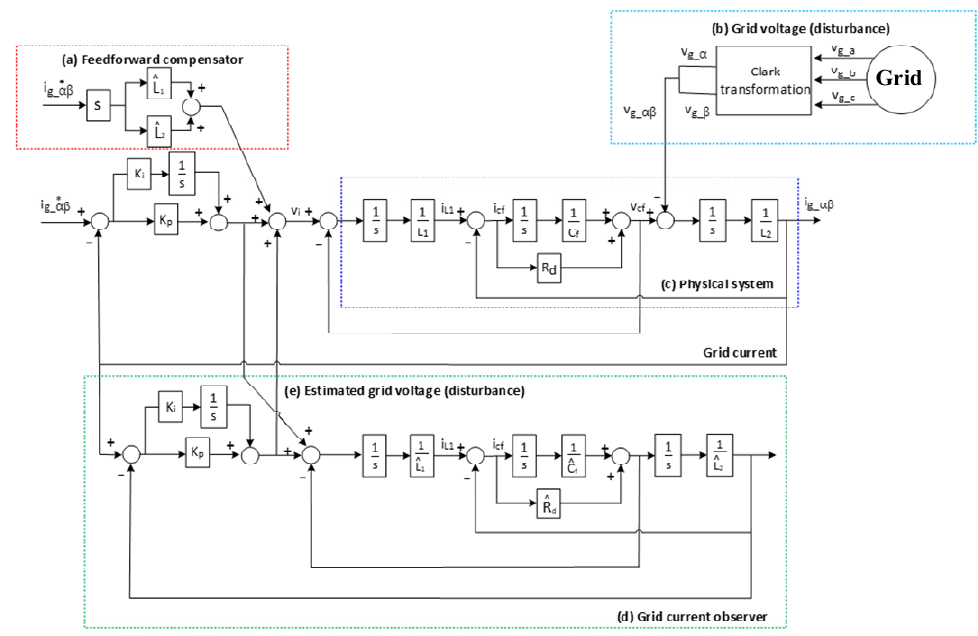
Figure 5. System block diagram with a grid current observer for disturbance rejection in a GCI current control system.